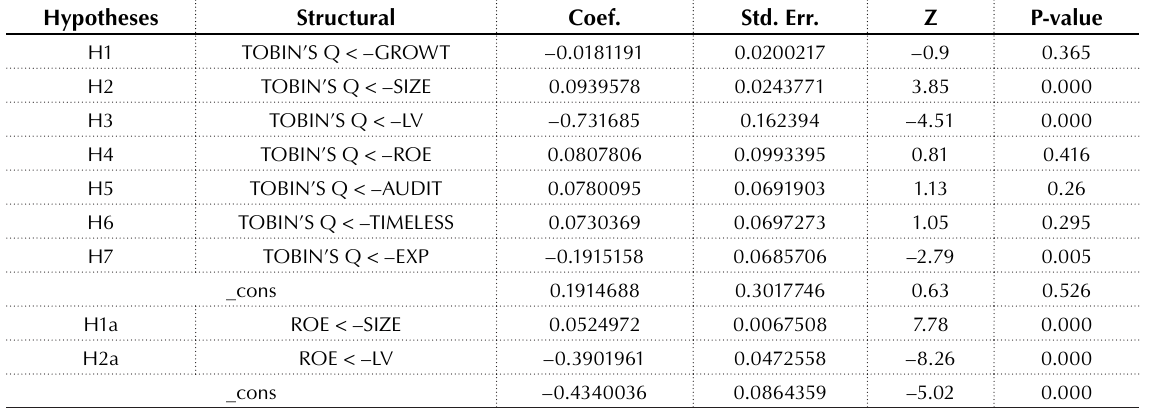
Table 5. Multivariate regression result with dependent variable Tobin’s